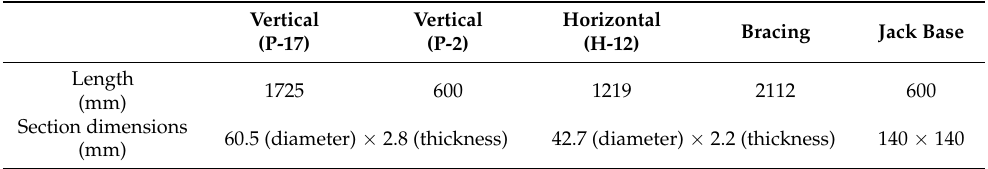
Table 4. Geometric dimensions of experimental members.